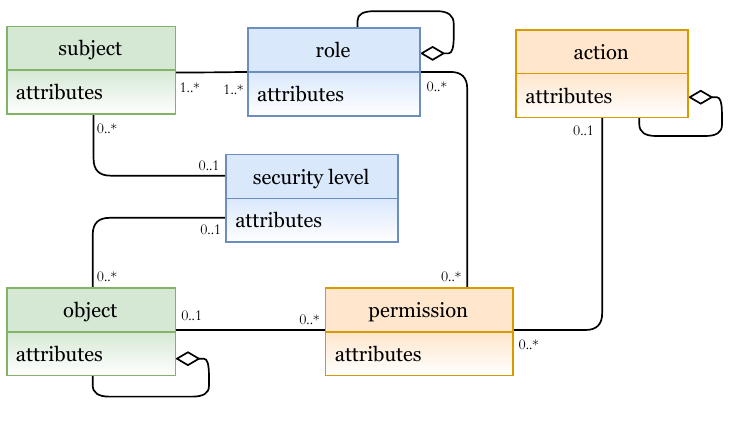
Figure 14. Hybrid MAC/RBAC model.